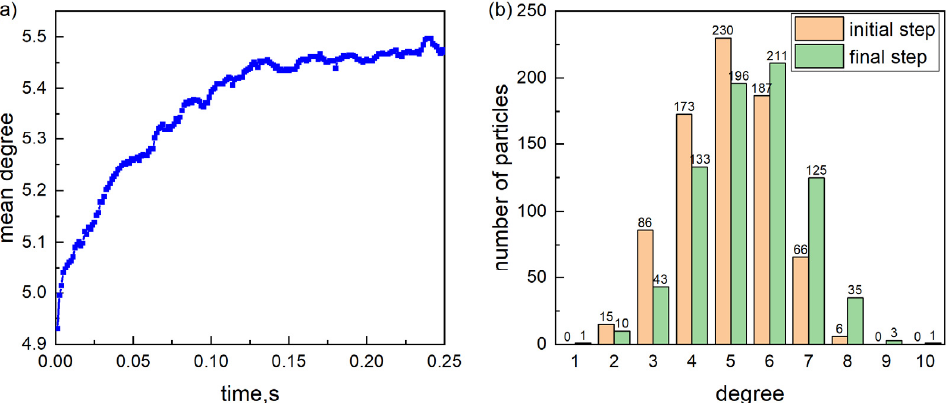
Figure 8. ( a ) Mean degree of porous media over time. ( b ) Comparison of degree distribution be- tween the initial and final time